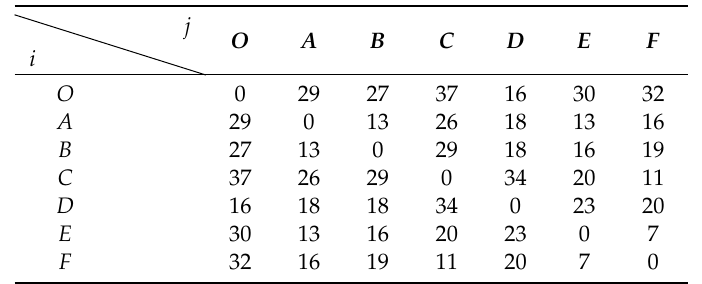
Table 10. Distance matrix (unit: